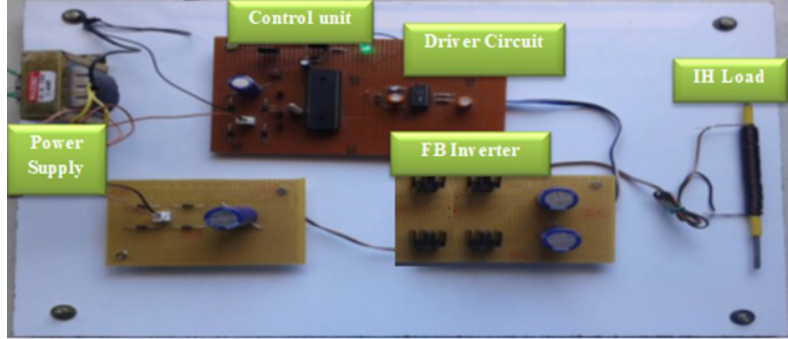
Figure 20. Test setup of FB